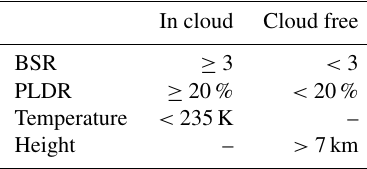
Table 1. Thresholds of the cloud mask. In cloud Cloud